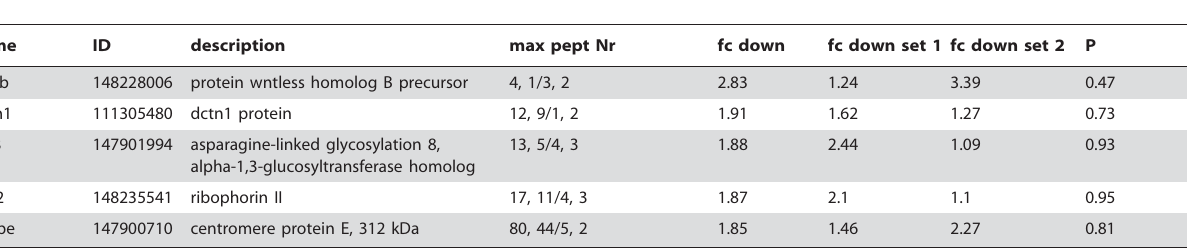
Table 3. Proteins reduced on chromatin in the absence of APC, but with unchanged dynamics of chromatin